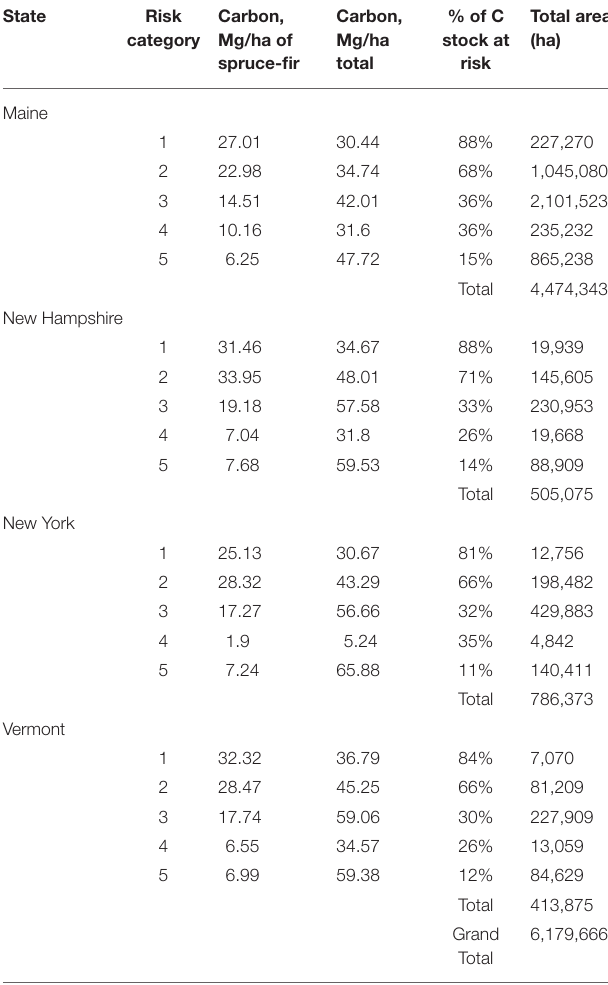
TABLE 1 | Mean forest carbon (C) stocks and area allocated by SBW risk category (see Table 2 ). State Risk